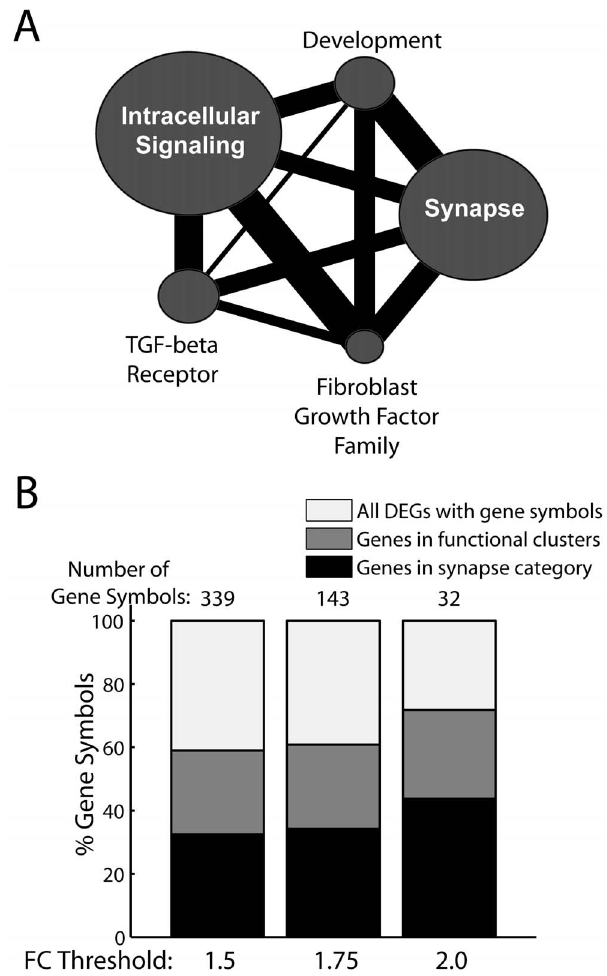
Figure 8. Differentially expressed genes were grouped into functional clusters related to the synapse, the fibroblast growth factor family, and other processes. A, The genes up- regulated at 5 days were grouped into 13 significantly enriched annotation clusters (p , 0.01) using the DAVID bioinformatics resources. These clusters were then further condensed into 5 categories depending on the biological relationships between the clusters’ annotation terms. Each of the five circles shown here represents one gene category. The area of the circle is directly proportional to the number of genes in that category. The thickness of the line connecting any two circles is proportional to the degree of overlap between the connected categories, indicated by the percentage of genes in the smaller of the two that are also present in the other. B , To estimate the effect of tightening the criterion for selecting differentially expressed genes on the rate of false positives, we successively increased our fold- change threshold from 1.5, to 1.75, and then 2.0 fold, and examined, at each threshold, the proportion of genes categorized into functionally enriched clusters. The percentages of genes remaining in any clusters (dark grey bars) and in the synapse category (black bars) were relatively unchanged as the fold-change threshold was increased. Assuming that the ‘‘true’’ proportion of "clusterable" genes is itself independent of the fold-change threshold, this observation implies that the false positive rate would probably not be much lower even with a more stringent fold-change threshold. DEG, differentially expressed